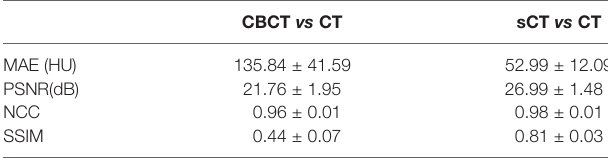
TABLE 1 | Numerical comparisons of CBCT and sCT with CT images.